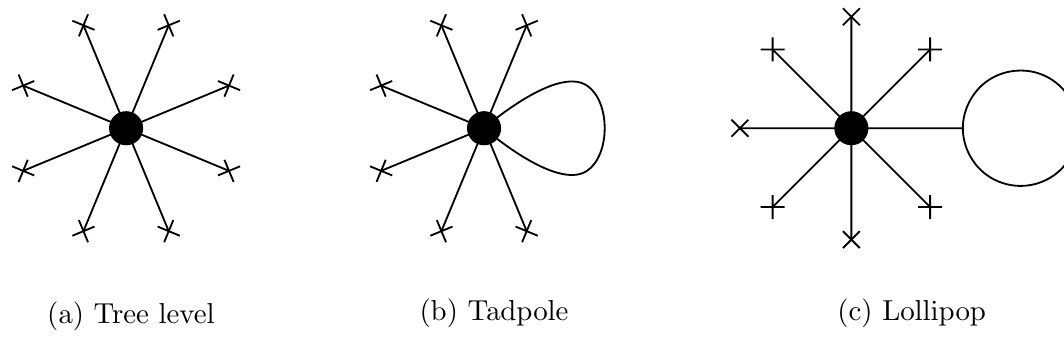
Figure 1 . Diagrams (identical to the ones of [25]) that contribute at tree level (a) and one-loop order (b)-(c) to a single-trace operator such as h tr Z L i L =8 (in the planar limit). The black dot denotes the operator and the crosses signify the insertion of the classical